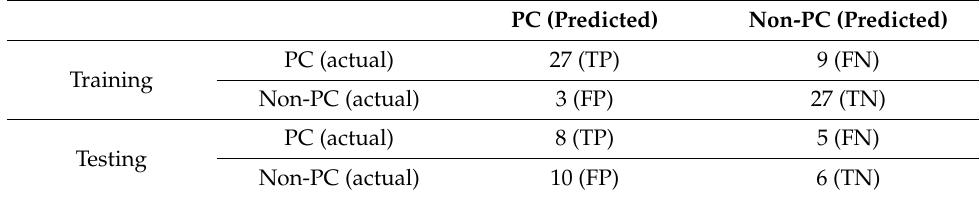
Table 3. Confusion matrix for the ANN.